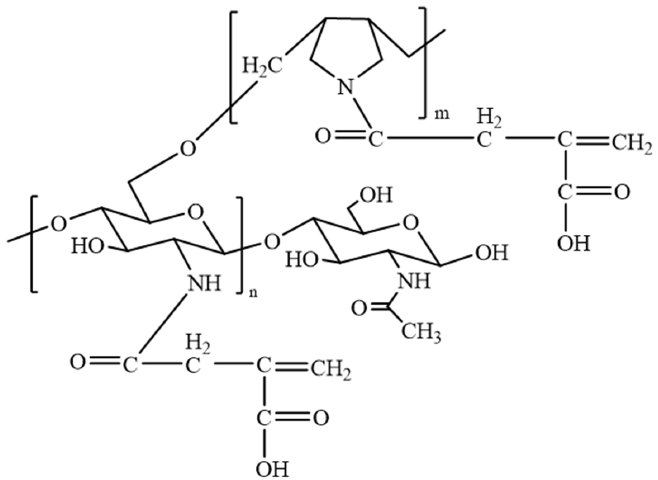
Figure 3. SEM Morphology of the superabsorbent ( b ) as compared to unmodified chitosan ( a ).